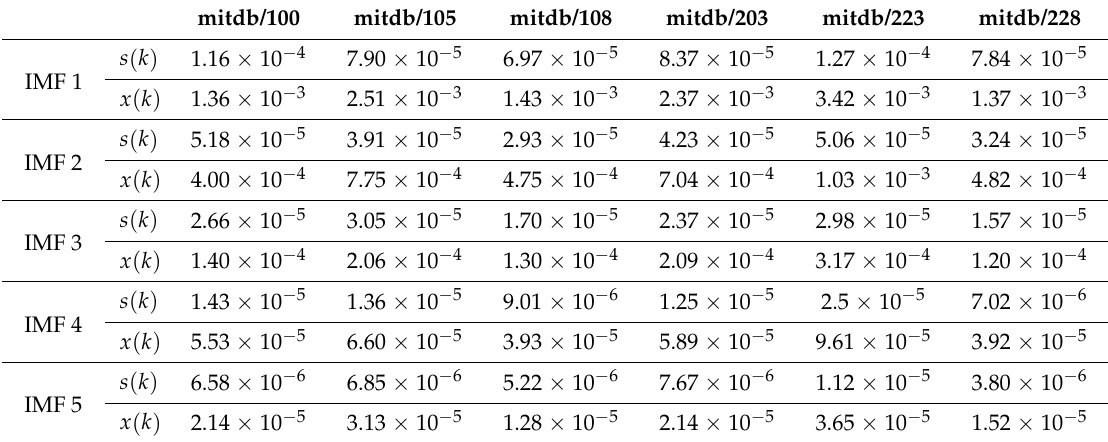
Table 2. The σ | ˆ for clean signal s ( k ) and noisy signal x ( k ) with EMG noise ( SNR = 5 dB). N ( f ) | Table 2. The 𝜎 |(cid:3015)(cid:3553)((cid:3033))| for clean signal 𝑠(𝑘) and noisy signal 𝑥(𝑘) with EMG noise ( 𝑆𝑁𝑅 = 5 dB )